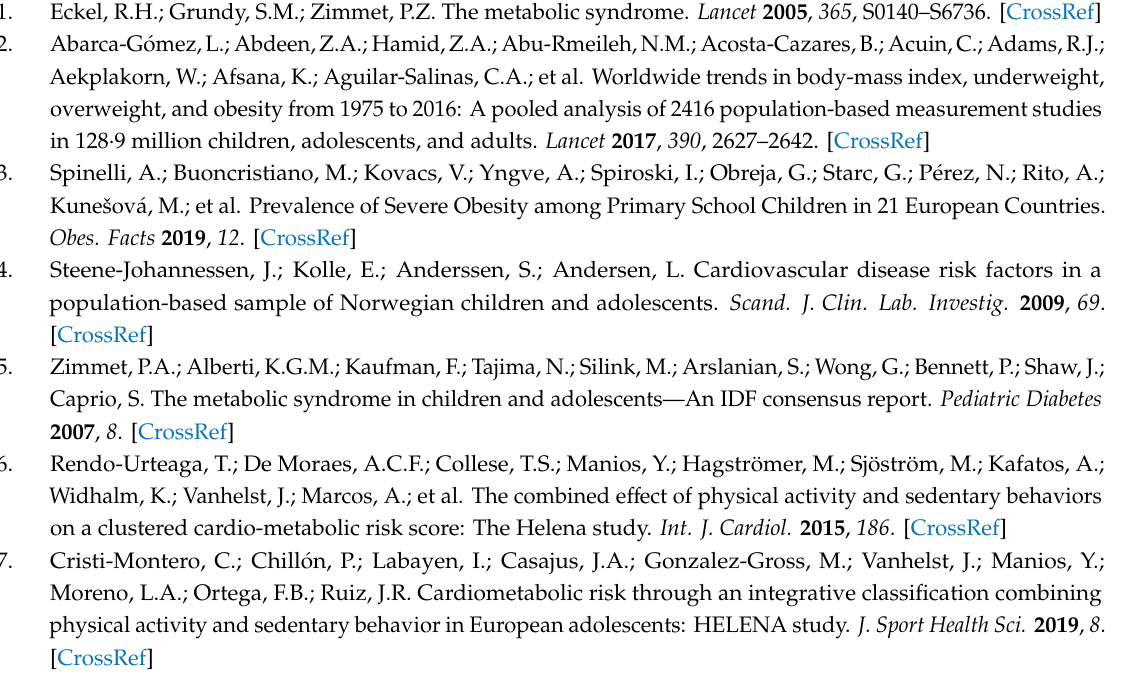
Table S1: Mediterranean diet score items specified in g / day displayed in sex-specific median intake in HELENA participants with dietary information available, Table S2: Main characteristics of the 21 single nucleotide polymorphisms (SNPs) included in the obesity genetic risk score (obesity-GRS), Table S3: Comparative analysis of the 21 single nucleotide polymorphisms (SNPs) included in the obesity genetic risk score (obesity-GRS) by sex, Figure S1: Interaction models between HOMA, diastolic blood pressure (DBP) and mean arterial pressure (MAP) and Mediterranean Diet (MD) according to the obesity genetic risk score (obesity-GRS) modulation in female. Obesity-GRS values (18–28) are displayed according to our population